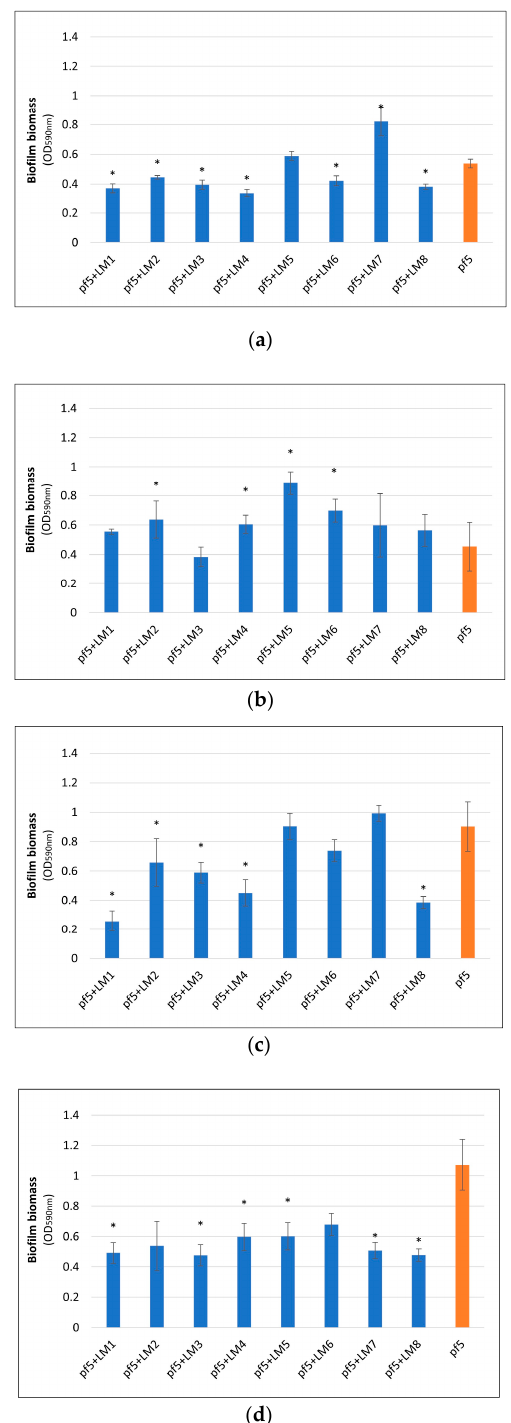
Figure 1. Biofilm biomass (OD 590 nm ) of P. fluorescens pf5 in mono- and dual-species with L. monocytogenes strains on a polystyrene (PS) surface at 12 °C for 168 h. The results are expressed as an average of five replicates and the bars represent the standard deviations. The asterisk (*) indicates statistically significant difference between the mono- and dual-species samples for the same incubation time (* p < 0.05). ( a ) 48 h, ( b ) 72 h, ( c ) 96 h, and ( d ) 168 h.